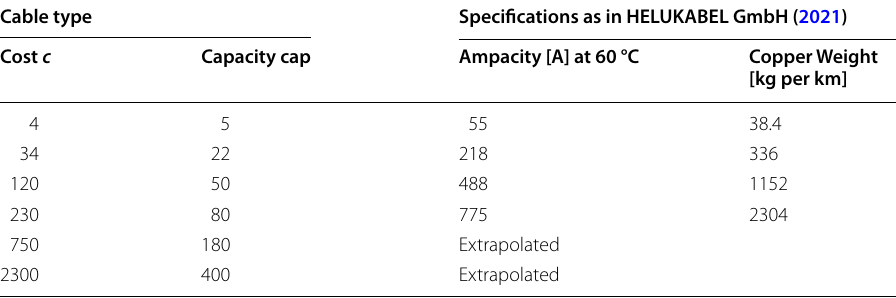
Table 2 Cable types used in simulations